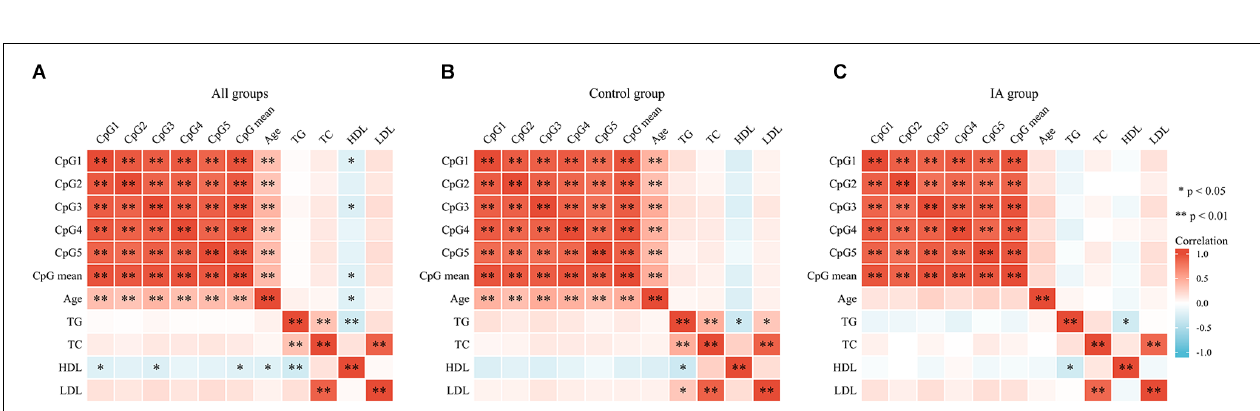
FIGURE 2 | The correlations among GpGs methylation and clinical data in different subgroups. (A) The correlation analysis in all groups. (B) The correlation analysis in the control group. (C) The correlation analysis in IA group. The correlations among the five CpGs methylation were analyzed using Pearson’s correlation test, ∗∗ p < 0.01; ∗ p <